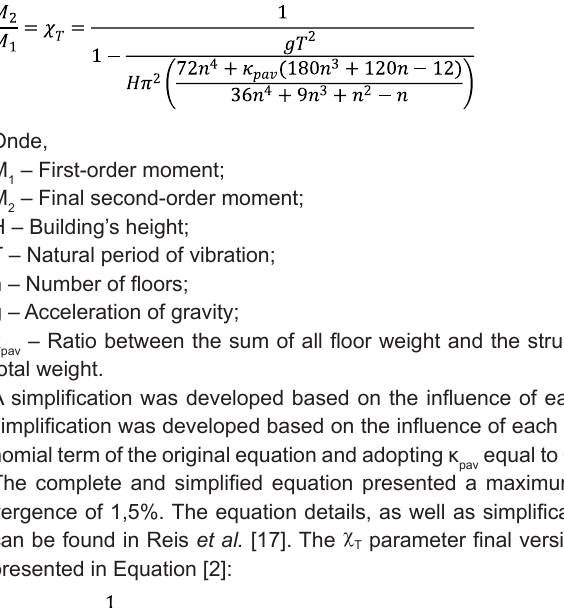
Generalized model adopted by Reis et al.